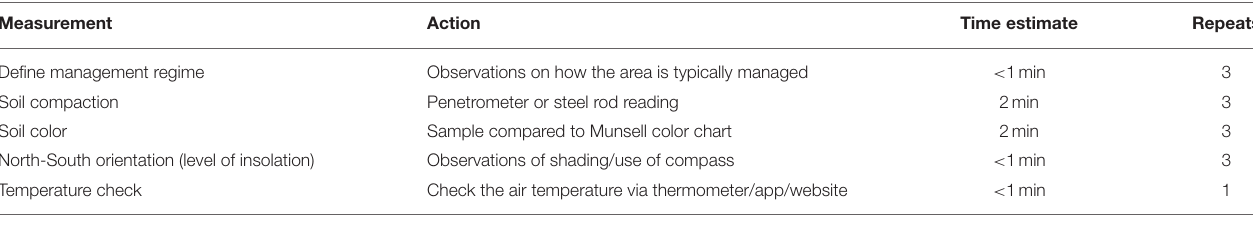
TABLE 4 | Estimates of citizen scientist measurement times required to complete the classification flow diagram ( Figure 5 ), assuming three repeat measurements within the sampled green space.